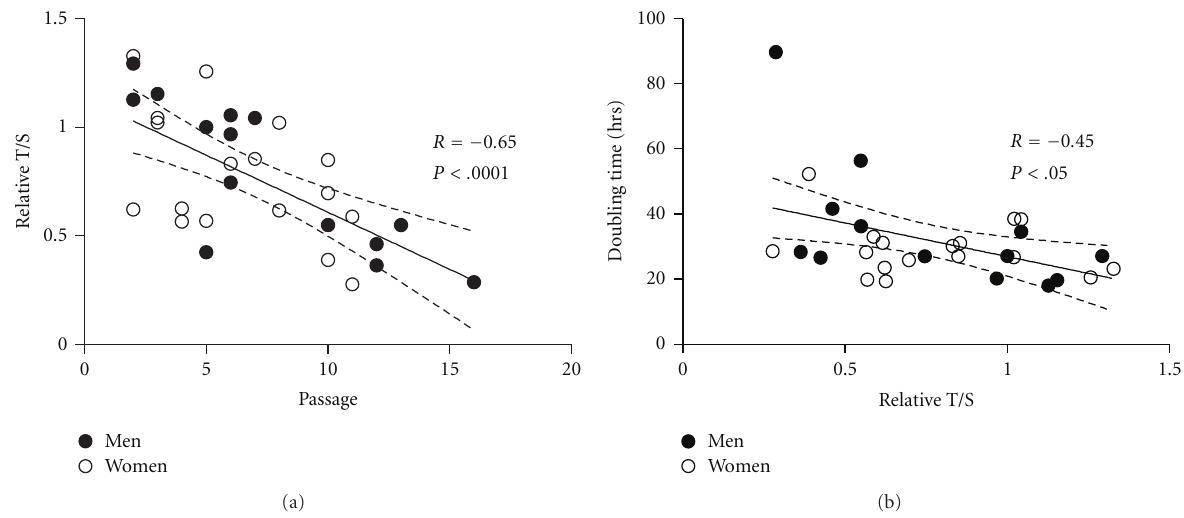
Figure 7: Plot of average telomere length (relative T/S) against passage number and doubling time versus T/S. (a) Relative telomere length expressed as ratio of T/S by quantitative real-time PCR analysis shows a decrease in T/S with increasing passage numbers. (b) Plot of doubling time in hours against relative telomere length (T/S) and regression line. The correlation coe ffi cients of the linear regression line best fitting the data are shown. Filled circles indicate males ( n = 5 individuals) and open circles indicate females ( n =